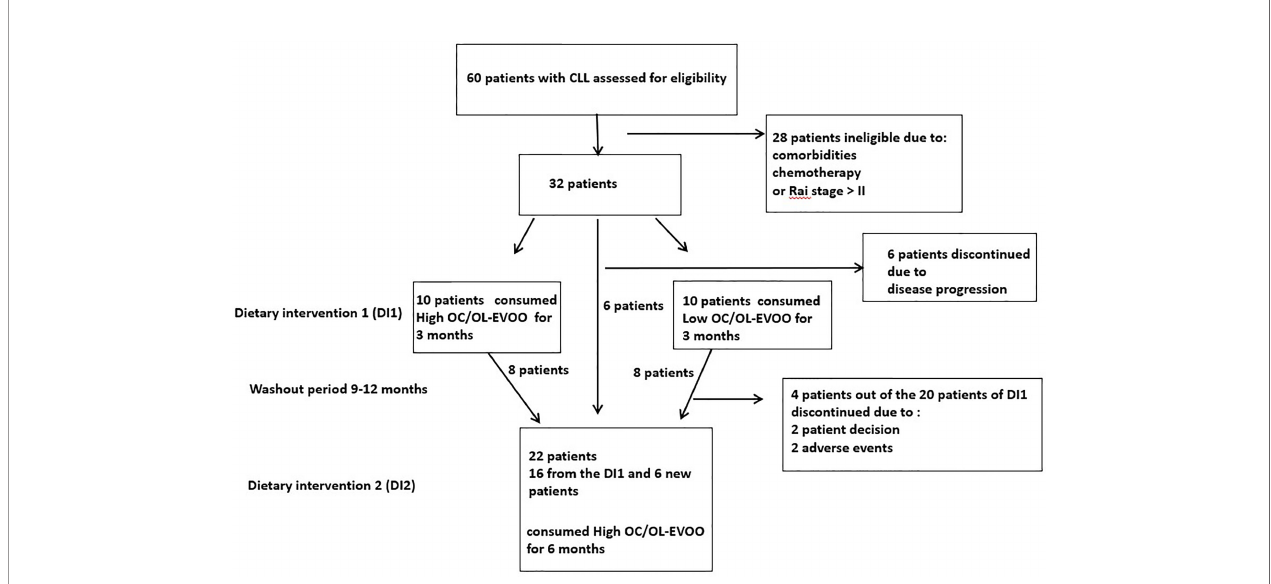
FIGURE 1 | Trial pro fi le: This fi gure displays the trial pro fi le, including the total number of screened and randomized subjects, the group distribution in both dietary interventions, and an overview of reasons for